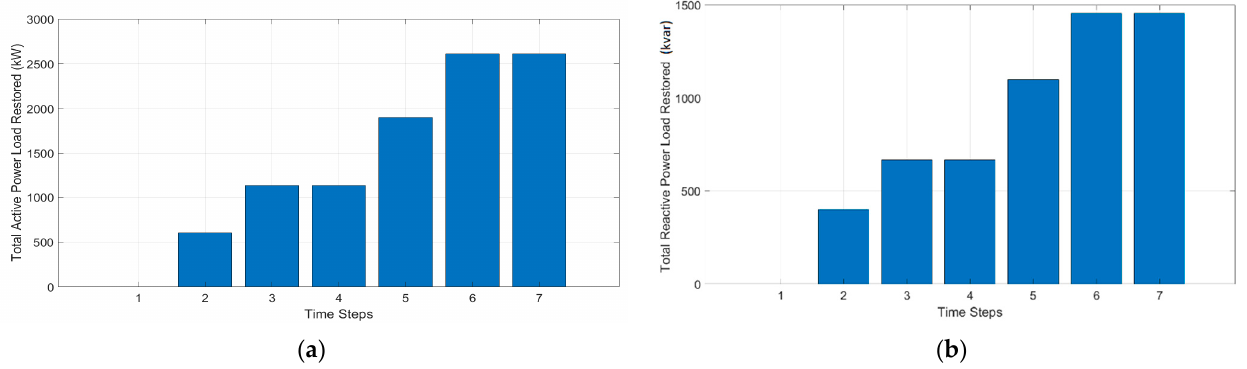
Figure 4. Total load value restored per restoration steps, ( a ) active power loads ( b ) reactive power loads.